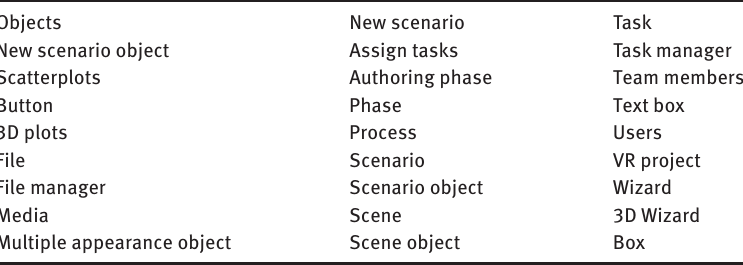
Table 2. A Filtered